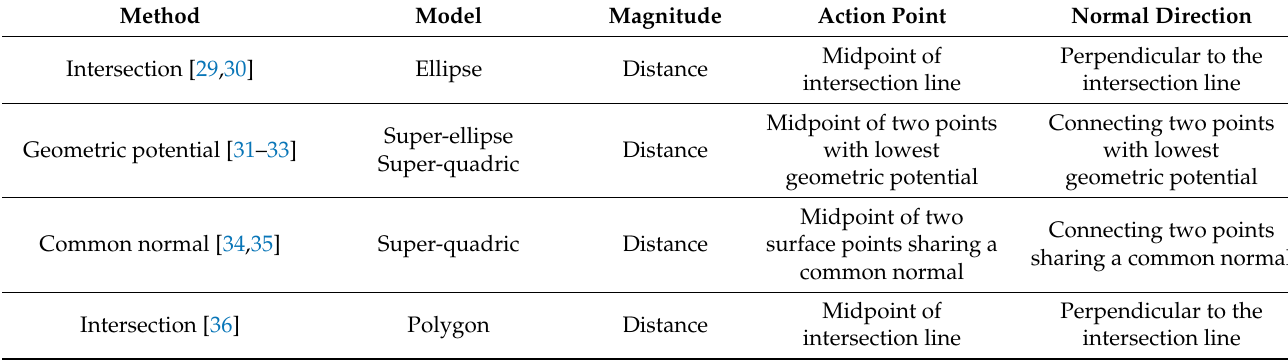
Table 1. Selected methods on overlap determination of non-spherical